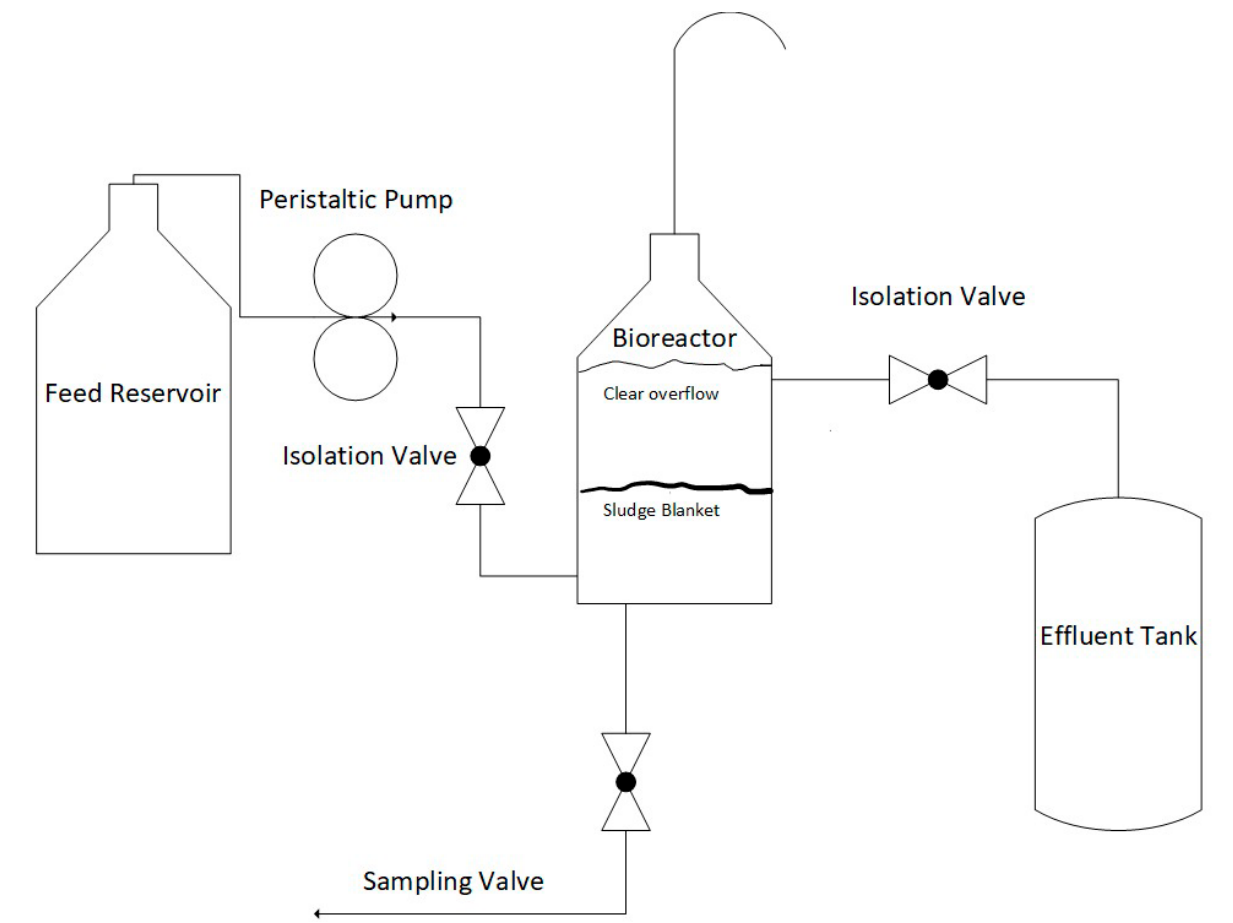
Figure 8. The UASB reactor .